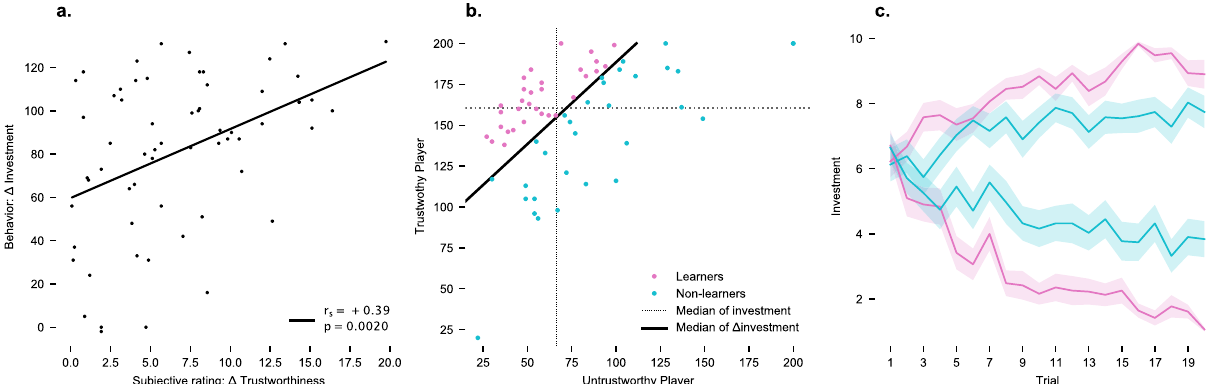
Fig. 1 Behavioral results. a Investment vs. trustworthiness. Behavioral trust ( Δ investment) correlates with post-experiment subjective ratings ( Δ trustworthiness rating), r s =+ 0.39, p = 0.002. b Participants ’ investment behavior. In total, participants invested more in the trustworthy player. The difference between the investment into the trustworthy and untrustworthy player ( Δ investment) was used to median-split the population into a subgroup that learned to differentiate (learners, magenta color) and those who did not (non-learners, cyan color). c Participants ’ investment behavior over time. After a few rounds, learners adapted their investment behavior to favor the trustworthy player. This differentiation was reduced in non-learners. Plot displays mean and